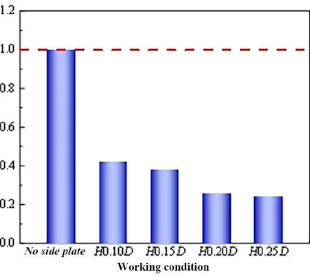
Figure 28. Crosswind displacement response at monitoring point 1 under a windspeed of 6 m/s and different side plate height conditions.